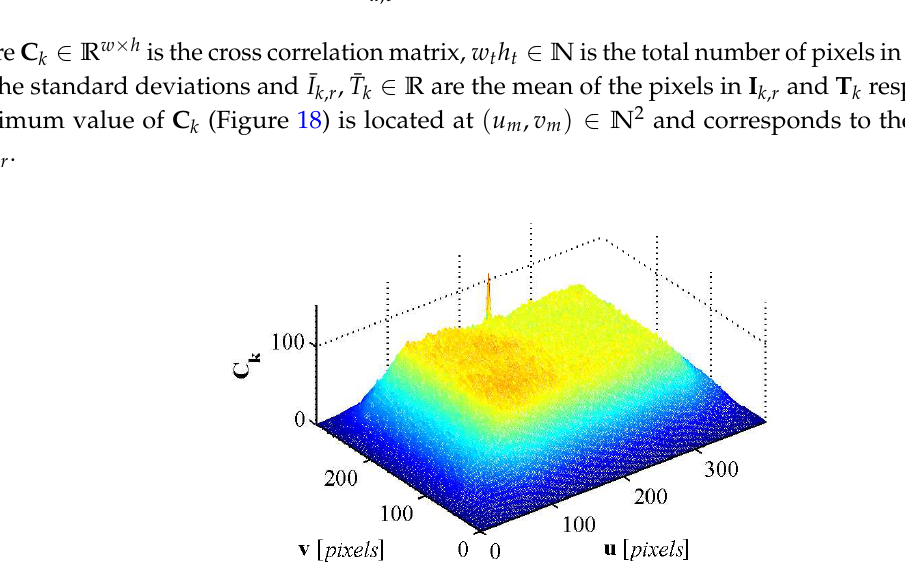
Figure 18. The cross correlation matrix C k generated from the template matching